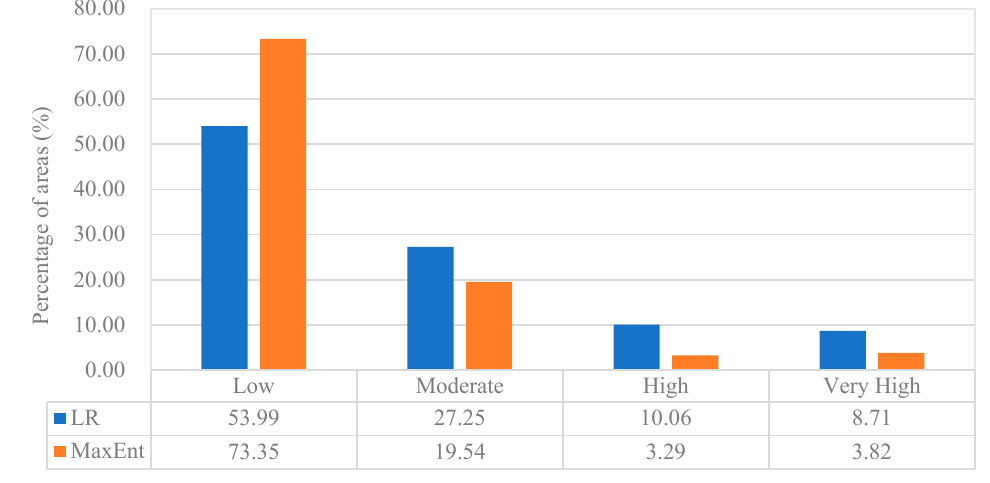
Figure 7. Area percentage of different landslide susceptibility zones within the research region using the models. Table 5. Percentage of landslide areas in each landslide susceptibility class.